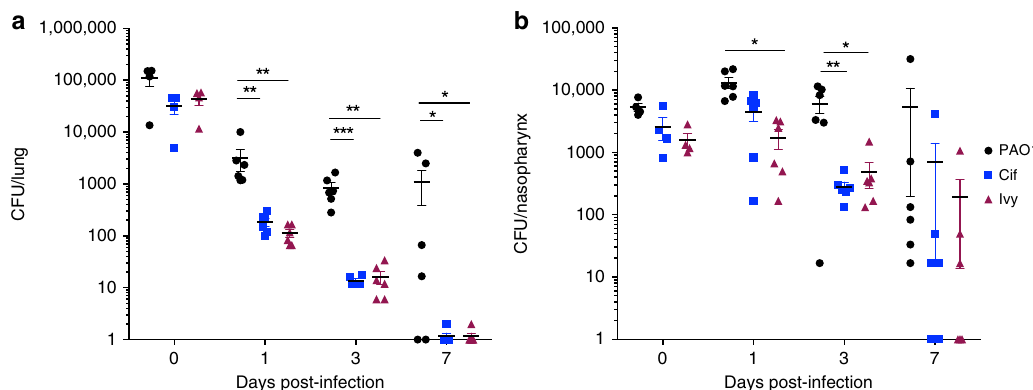
Fig. 4 Cif and Ivy contribute to establishment of lung infection. Mice were infected by intranasal instillation of 1 × 10 6 colony forming units (CFU) P. aeruginosa PAO1, or PAO1 with transposon insertions in cif or ivy . Mice were culled immediately after infection ( n = 4 per group) or at 1, 3 and 7 days post-infection ( n = 6 per group) and CFU in ( a ) lung and ( b ) nasopharynx determined by plating of tissue homogenates onto selective agar. Data are